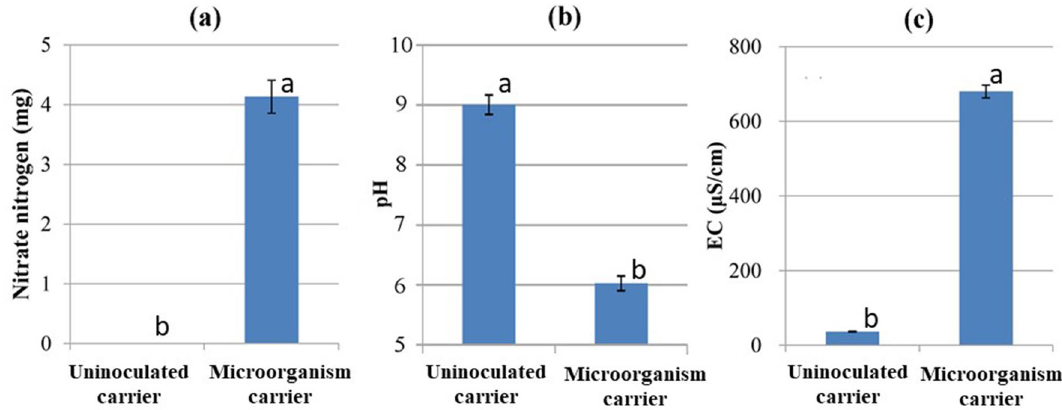
Figure 2. Comparisons between leachates from the inoculated rockwool carrier and leachates from the uninoculated rockwool. Comparisons of ( a ) nitrate–N, ( b ) pH, and ( c ) electrical conductivity (EC) of the leachate solutions from 100 mL of inoculated or uninoculated rockwool. The carrier received 1 g of bark compost as inoculum. All tubes received 0.1 g of fish-based soluble fertilizer every day and were rinsed with 100 mL of water the next day. Values are means ± SD ( n = 3). Values of a property labelled with the same letter do not differ significantly (Fisher’s protected LSD test, P <